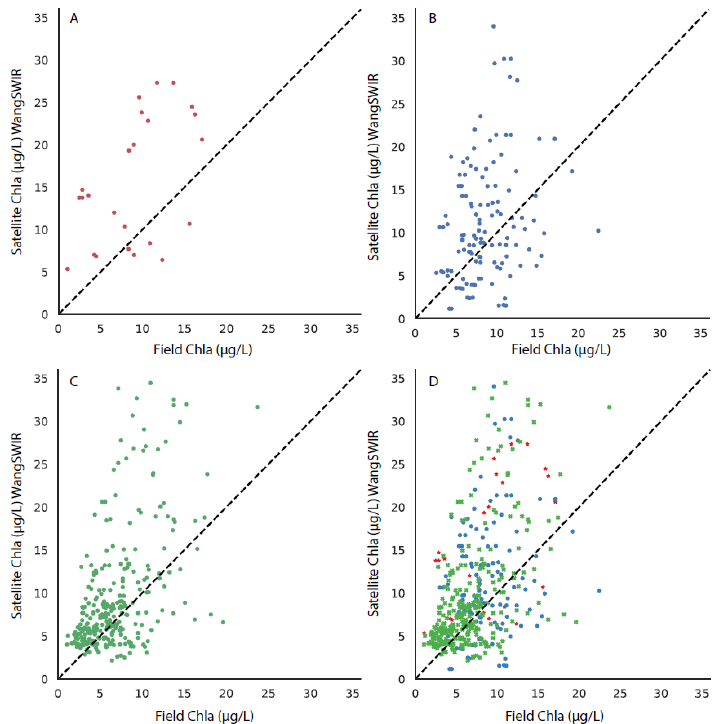
Figure 6. The matchup between the field chla and the MODIS-Wang algorithm, with the 1:1 line shown in each subplot for stations in ( A ) the upper bay, ( B ) the middle bay, ( C ) the lower bay, and ( D ) all stations, with the upper, middle, and lower bays differentiated by symbol color and style. J. Mar. Sci. Eng. 2022 , 10 , x FOR PEER REVIEW